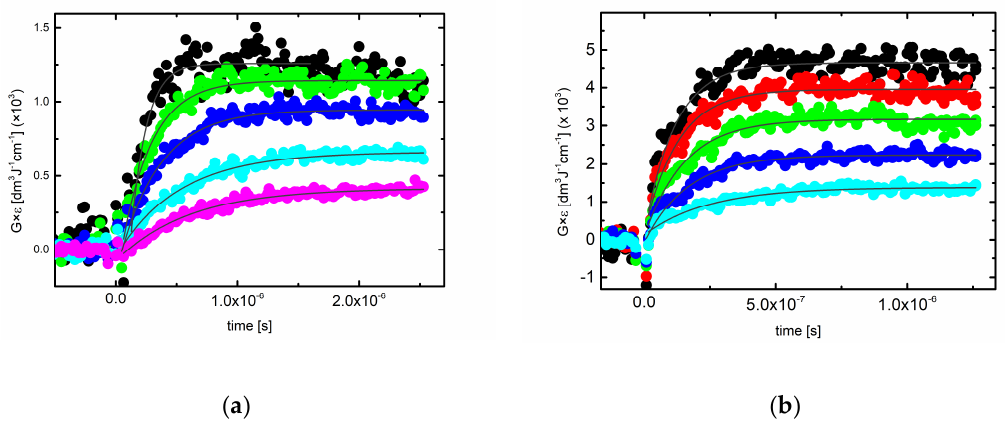
Figure 5. Time profiles representing growth of transient absorptions at λ = 370 nm recorded after the electron pulse in N 2 O-saturated aqueous solutions containing 0.1 M NaN 3 at pH = 7 and various concentrations of ( a ) 3-MeQ and ( b ) 7-CN-3-MeQ: ( ▬ ) 0.05 mM, ( ▬ ) 0.1 mM, ( ▬ ) 0.2 mM, ( ▬ ) 0.3 mM, ( ▬ ) 0.4 mM and ( ▬ ) 0.5 mM.